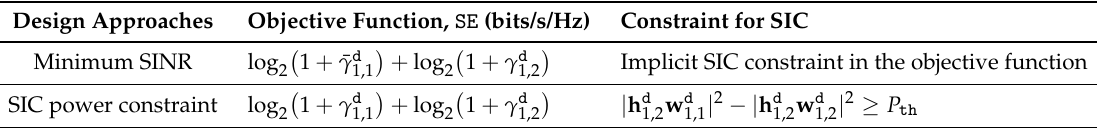
Table 2. Objective functions and constraints for SIC design in NOMA